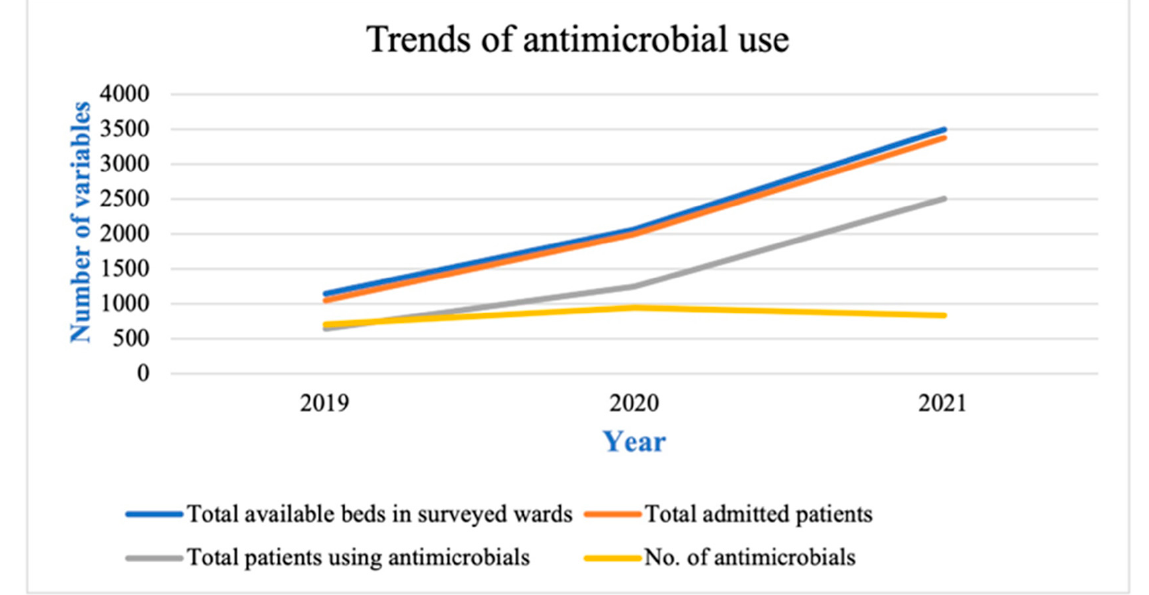
Figure 5. Trends of antimicrobial use in hospitalized COVID-19 patients along with total available beds in surveyed hospital wards.